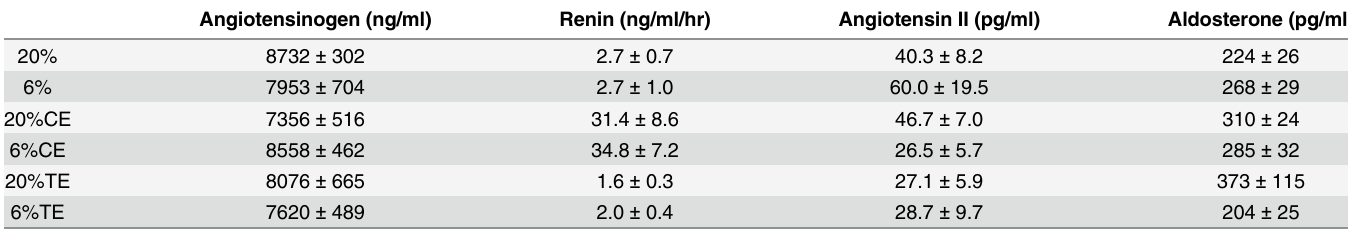
Table 1. Effect of Continuous or Transient Enalapril on Systemic Renin-Angiotensin System in Control and Programmed Rats. Angiotensinogen (ng/ml)